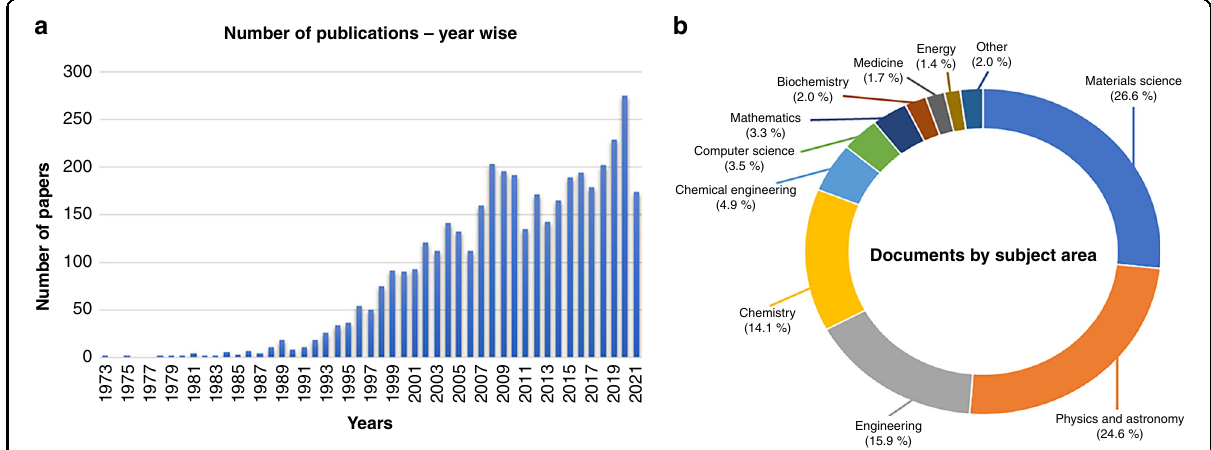
Fig. 1 Progress in pulsed laser synthesis. a Number of publications in the Scopus database by the search term “ pulsed laser synthesis ” from 1973 to 2021. b Contribution of the works by subject (Source: Scopus database, searched on August 31,